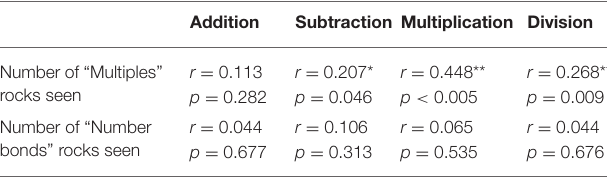
TABLE 1 | Pearson correlation coefficients and significance for relationships between games played and improvement in performance for the four operations (n in all cells = 93). Addition Subtraction Multiplication Division Number of “Multiples” rocks